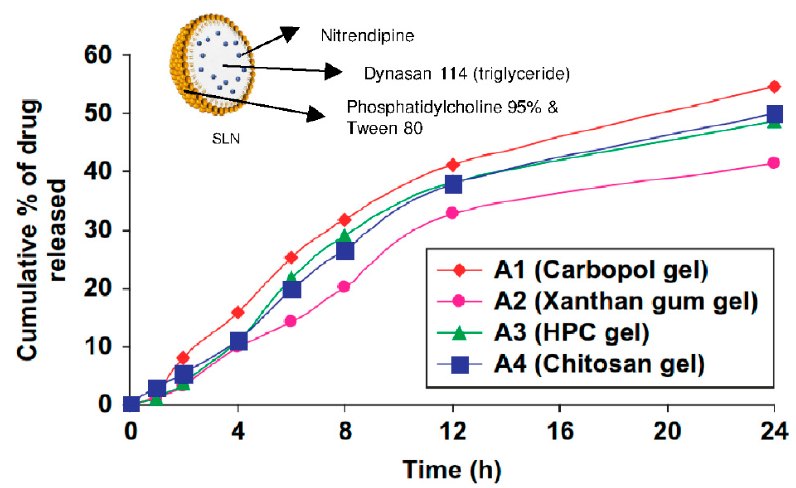
Figure 5. Cumulative time-release profile of nitrendipine-loaded SLN from different hydrogels. Adapted from [13].